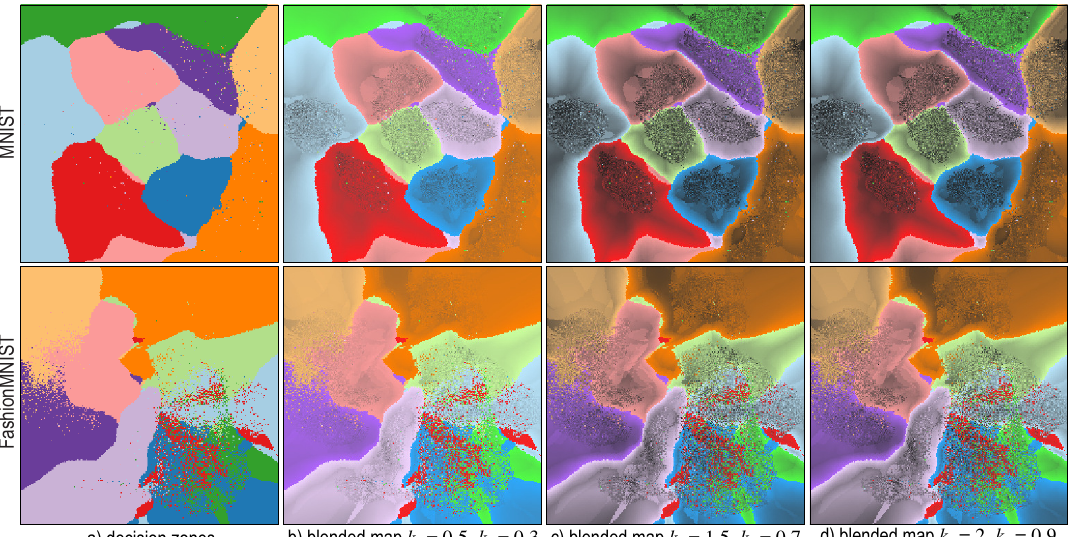
( a ) Dense map for MNIST (top row) and FashionMNIST (bottom row) datasets. ( b – d ) Combined dense map and distance-to-boundary maps for different k 1 and k 2 values.